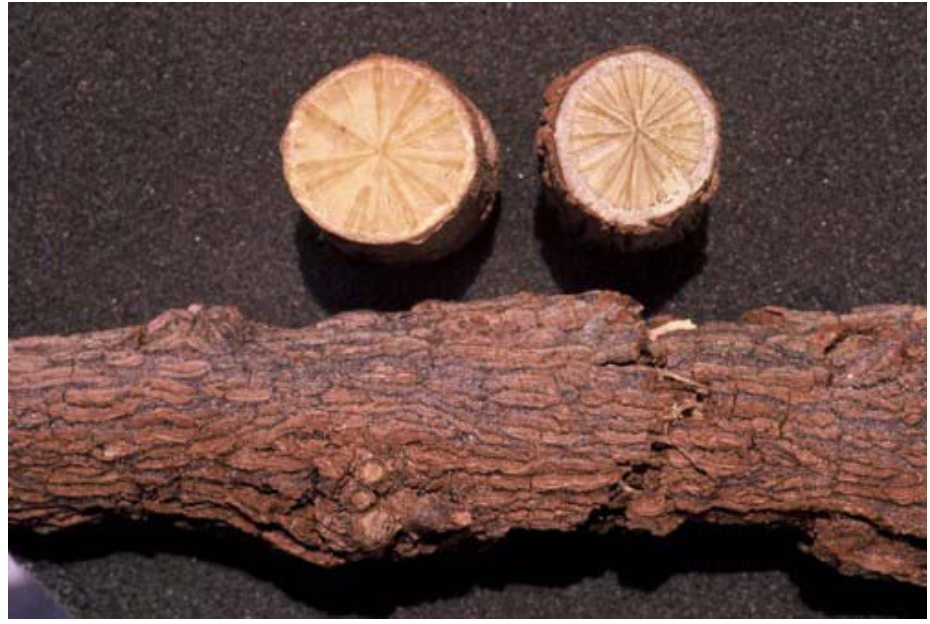
Figure 1. Rhizome of Cissampelos